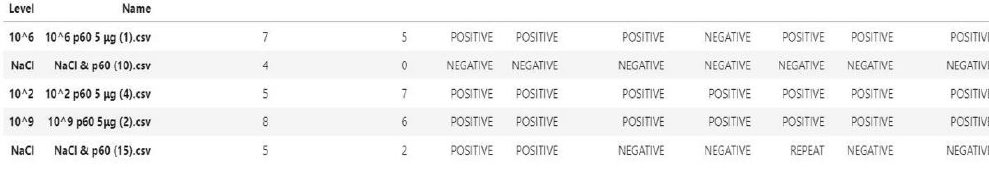
Figure 5. Calculation of the final results based on the feature vectors.